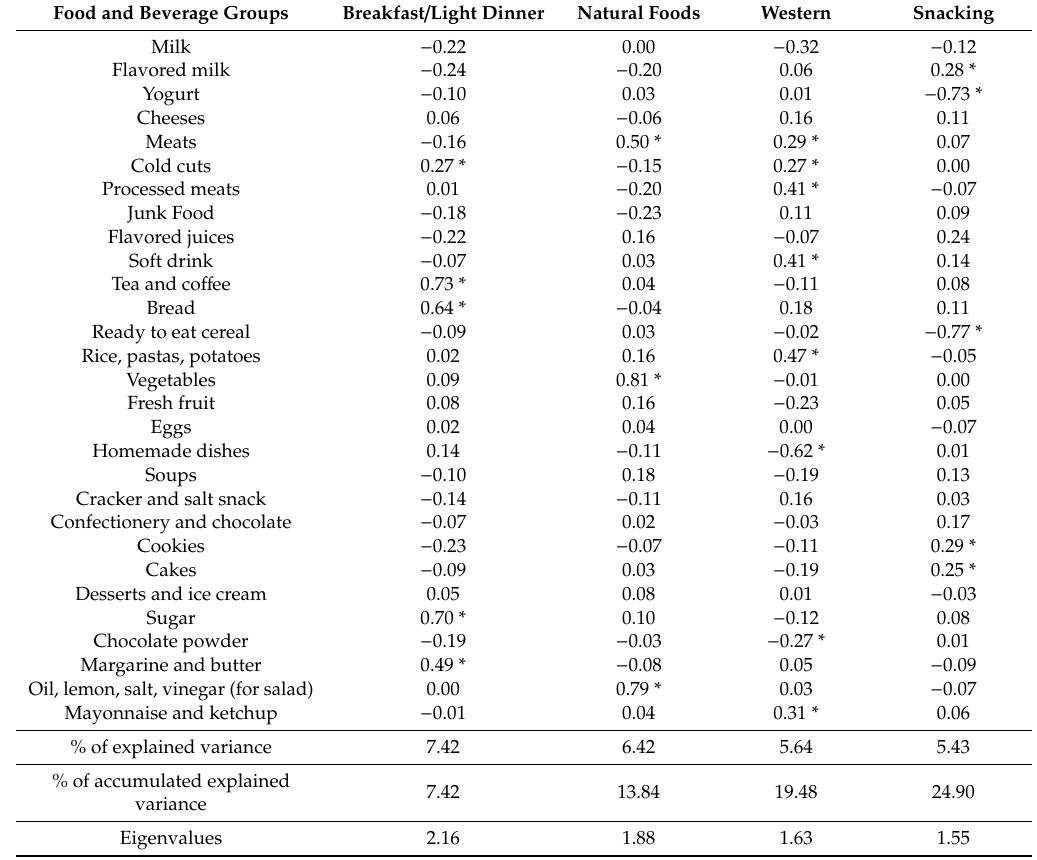
Table 2. Dietary Patterns practiced by GOCS adolescents ( n :882), Chile